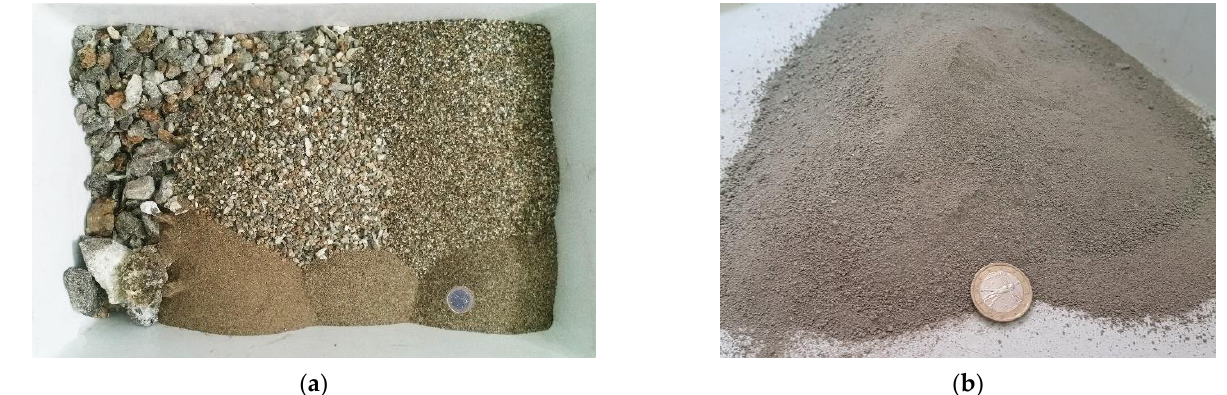
Figure 3. ( a ) Soil S1 selected for size and ( b ) clayey Soil S2 used in the